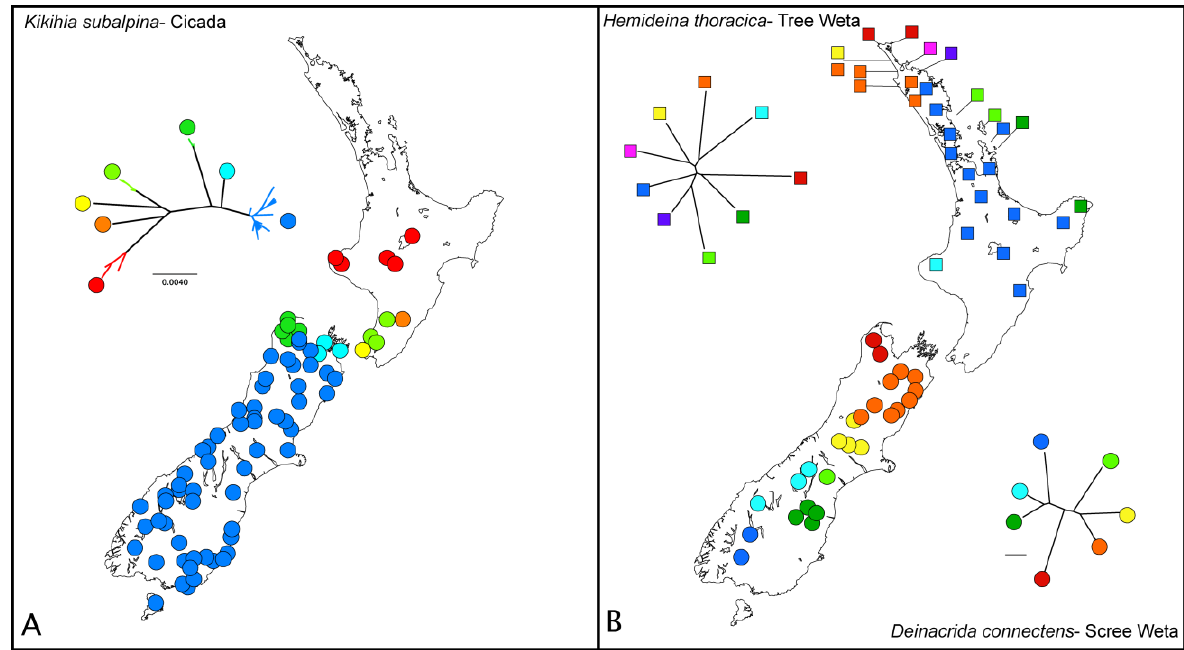
Figure 7. Exemplars of phylogeographic patterns revealed in species of New Zealand invertebrates. In each case mtDNA lineages are color coded and mapped, with cooler colors (blue, green) to south and warmer ones (reds) to north. Trees for A, C and F inferred using Neighbor-Joining of HKY distances in Geneious Pro v5.3.4 with mtDNA COI sequences download from GenBank; tree topology did not differ significantly from that originally reported. ( A ) Cicada Kikihia subalpina [59]; ( B ) Tree weta Hemideina thoracica only major mtDNA lineages for each species are indicated here [61], scree weta Deinacrida connectens [37]; ( C ) Within the stick insect Clitarchus hookeri [62], lineages associated with sexual populations are multicolored within dashed line whereas green populations are parthenogenetic; ( D ) The two New Zealand koura or freshwater crayfish Paranephrops are partitioned north and south, tree redrawn as above [47]; ( E )